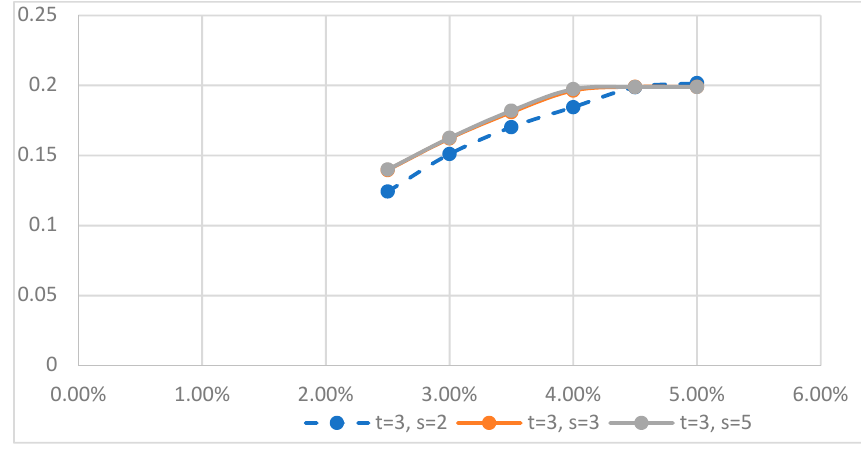
Figure 2. The dimension t = 3 with different s under guaranteed return rate (cid:1868)(cid:3556) (cid:2870) .